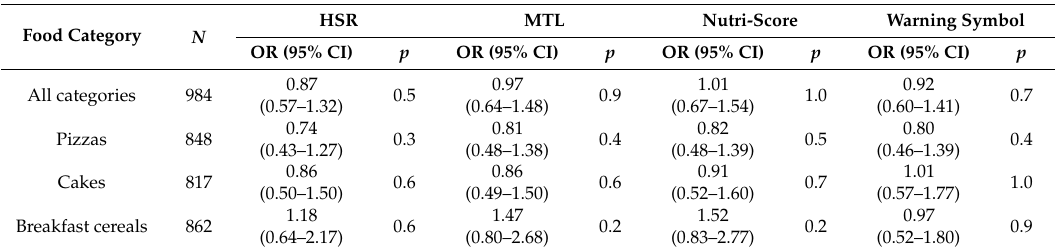
Table 2. Associations between the front-of-pack nutrition labels (FoPLs) and the change in nutritional quality of food choices.